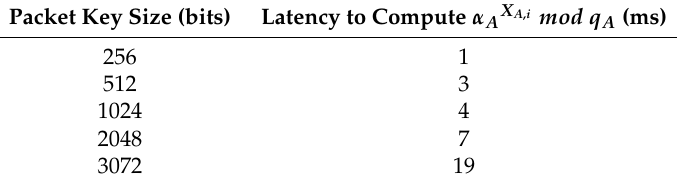
Table 2. Key-size varying latency for computing a blind value.